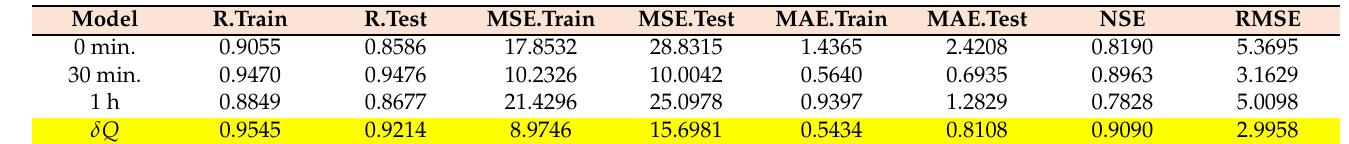
Table 2. LSTM forecasting models.